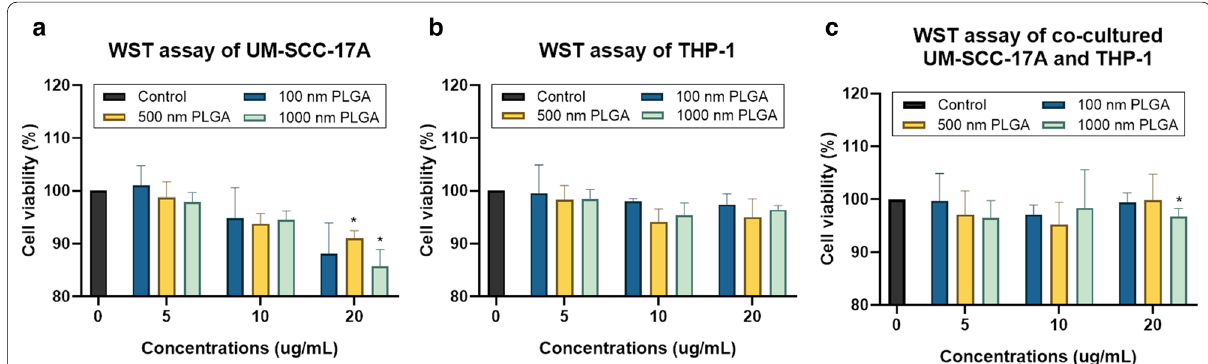
Fig. 2 Determination of cell viability in monoculture and co‑culture cells utilizing the WST assay. UM‑SCC‑17A ( a ) and THP‑1 cells ( b ), and